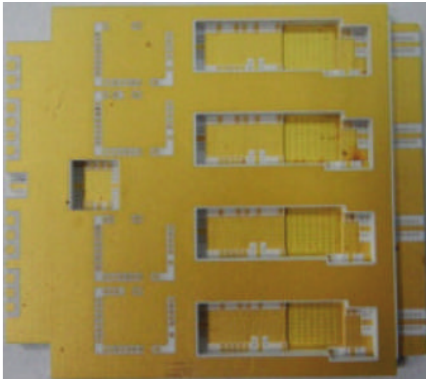
Figure 3: The realization of the LTCC housing cavity.